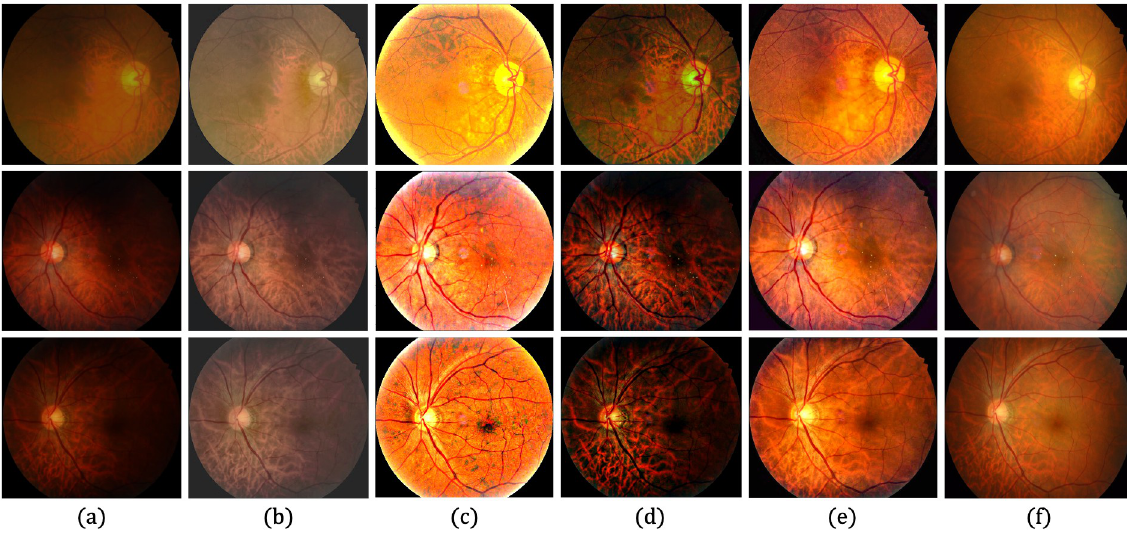
Fig 7. Qualitative comparison of three LQ image samples from SNUH private test dataset. (a) Input LQ images, and results using the methods of (b) Zhou et al. [42], (c) Gaudio et al. [88], (d) Dai et al. [89], (e) the proposed method, and (f) GT of (a).